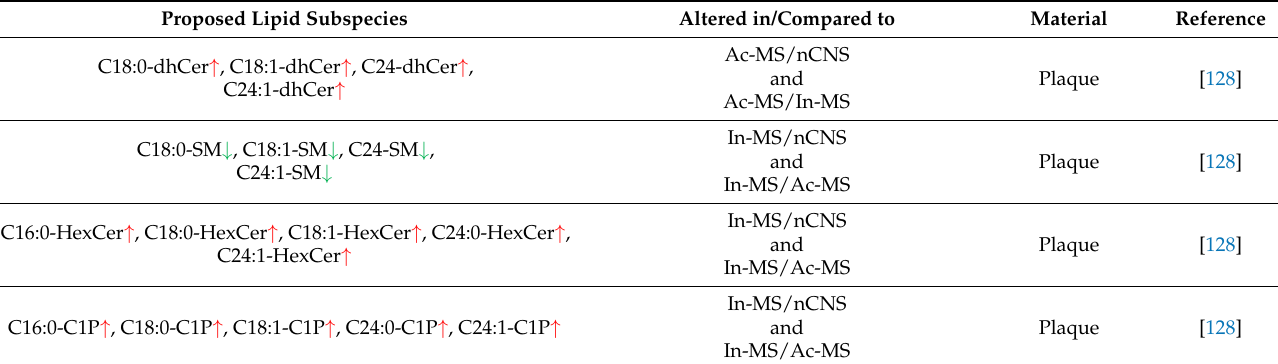
Table 1. Potential lipid markers in